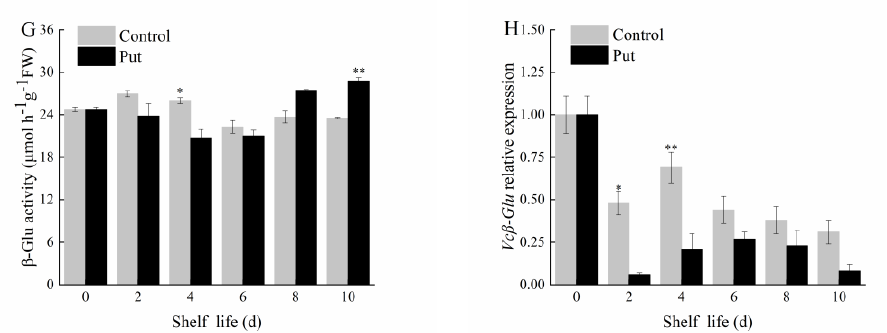
Figure 5. Changes in PG ( A ), β−Gal ( E ), and β−Glu ( G ) activity and VcPG1 ( B ), VcPG2 ( C ), VcPG3 ( D ), Vcβ−Gal ( F ), and Vcβ−Glu ( H ) relative expression of postharvest blueberry fruit at 20 °C. Mean ± SE of three replicate experiments are shown. Asterisks indicate significant differences between control and Put − treated fruit (* p < 0.05, ** p < 0.01).